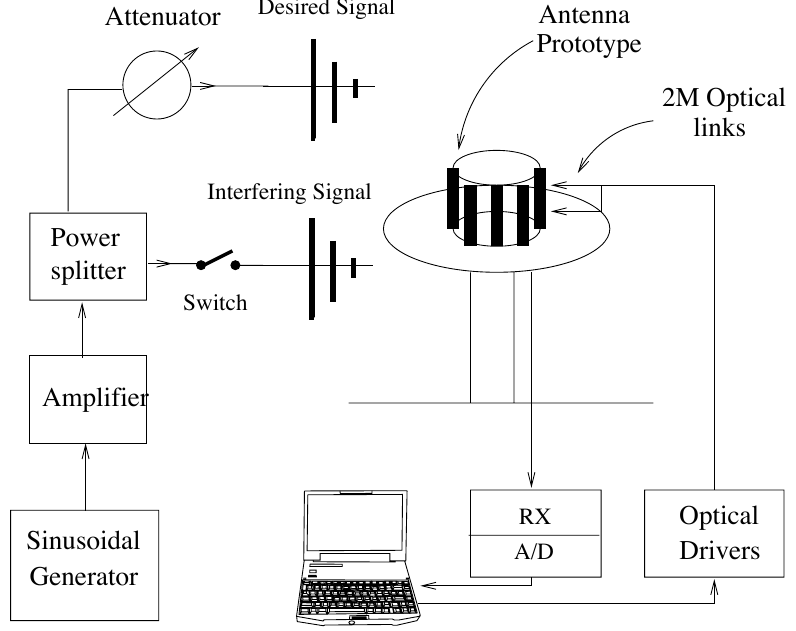
Figure 11. Experimental assessment for multiple interfering signals scenario. Experimental